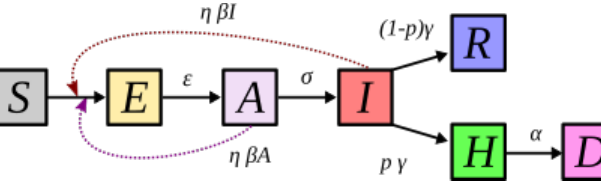
Figure S2 – Flow diagram of the SEAIRHD model. This SEAIRHD model corresponds to the ODE model detailed in eq. S1a to S1g. Susceptible individuals ( S ) can be